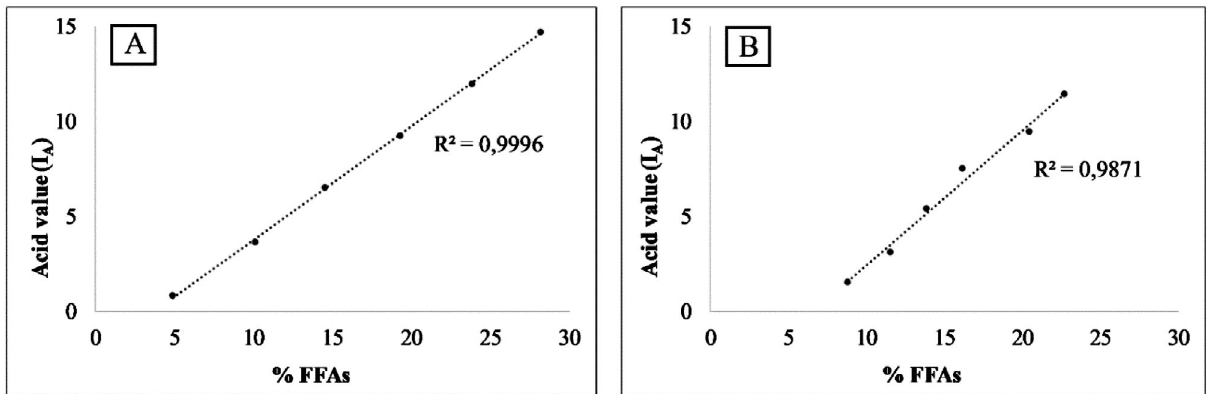
Fig 6. I A values in correlation to % FFAs (w/w) in PS 20 (A) and PS 80 (B)